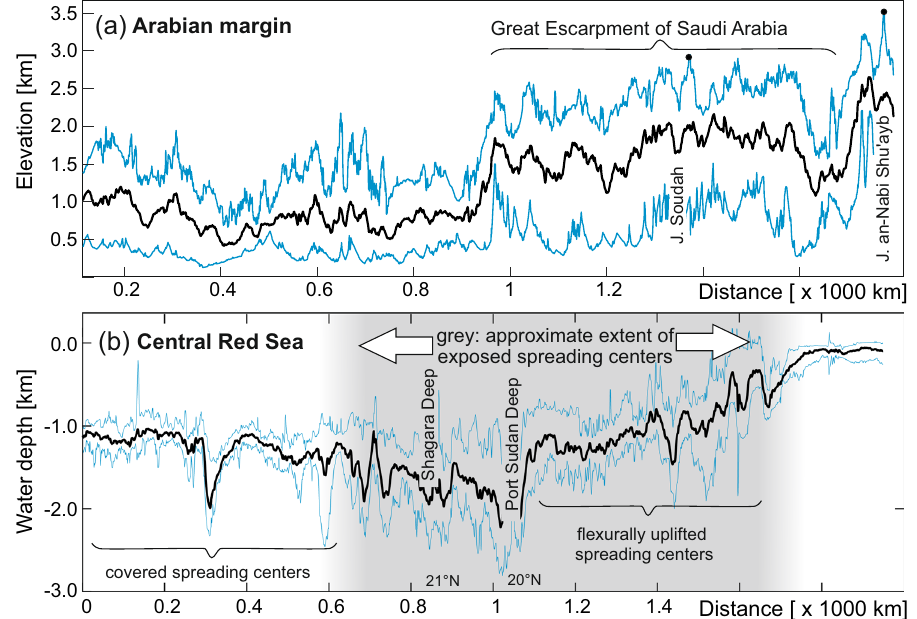
Fig. 4 | Curved topographic swath pro fi les 21 along the Red Sea margin. Swaths are near the divide along the Saudi Arabian margin (in a) and near the spreading centers in the Central Red Sea (in b) and are derived from the SRTM15plus data 37 .